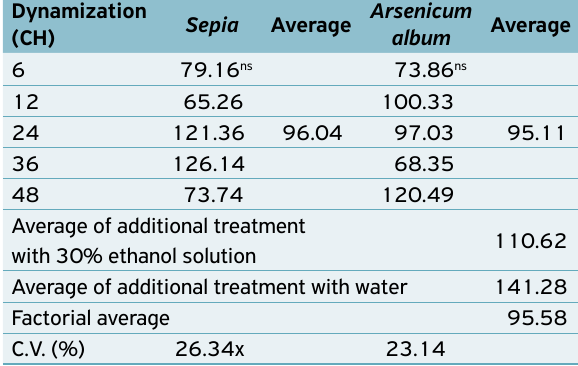
Figure 1. Area under the mycelial growth curve (AUMGC) of Macrophomina phaseolina in a PDA medium with dynamizations of the homeopathic drugs, Sepia and Arsenicum . Table 1. Quantity of micro-sclerotia of Macrophomina phaseolina in a PDA medium supplemented with dynamizations of the homeopathic drugs, Sepia and Arsenicum album